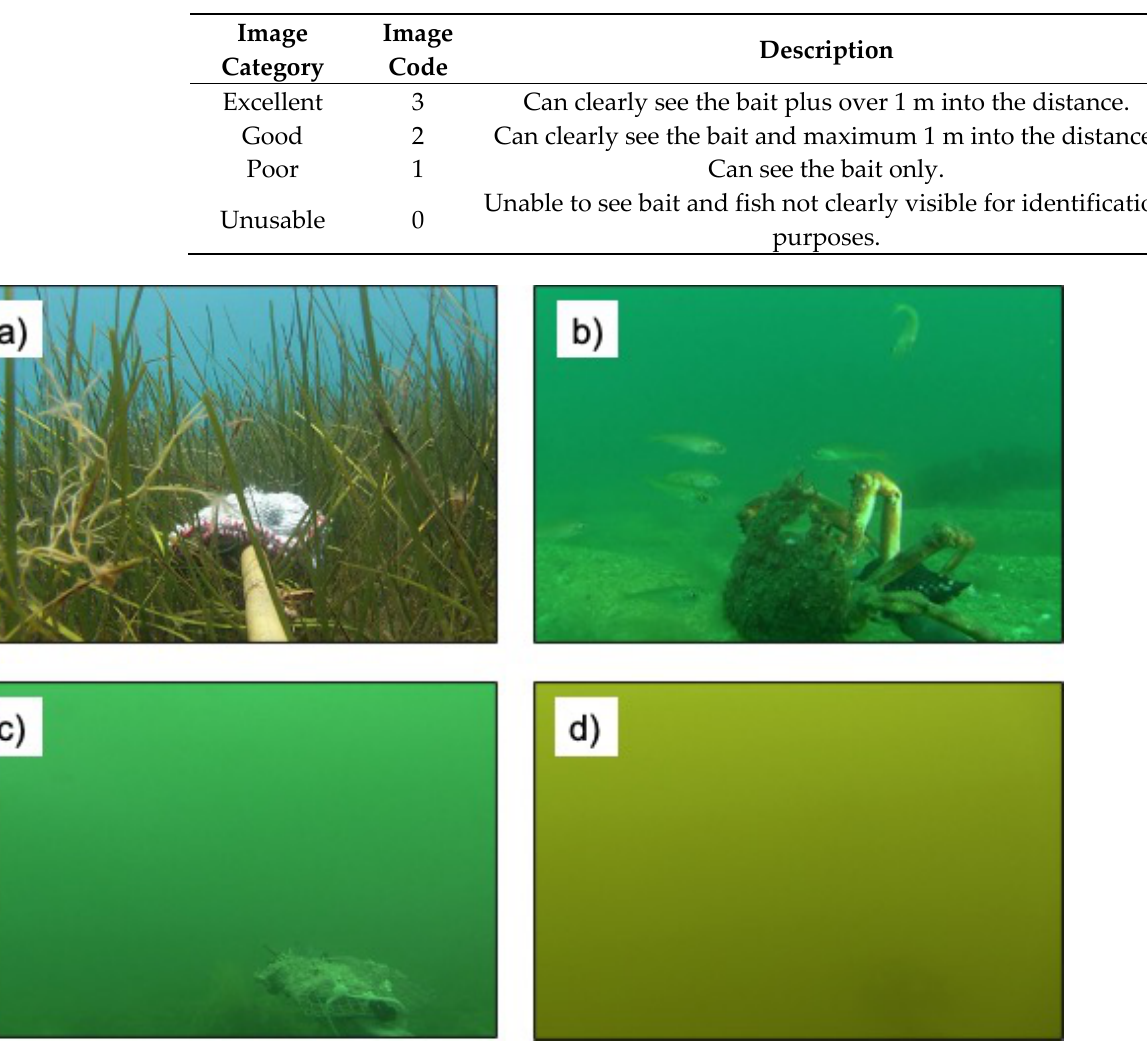
Table 1. Image quality criteria categories, code and description for BRUV footage in compiled database.